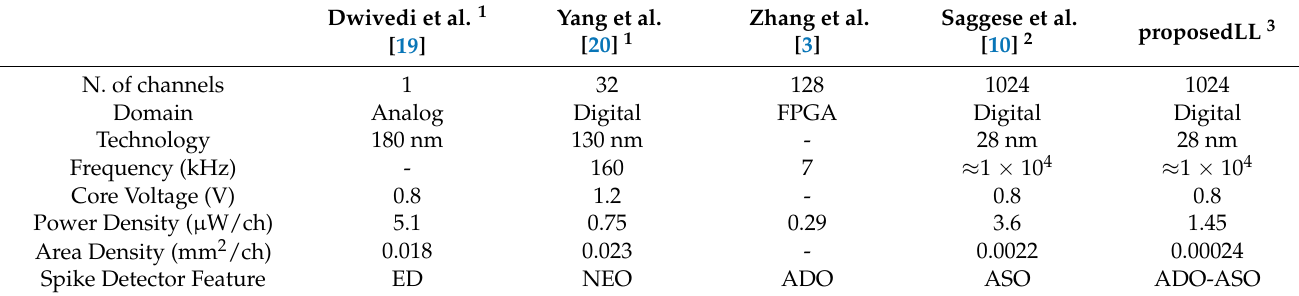
Table 5. Comparison with the state of the